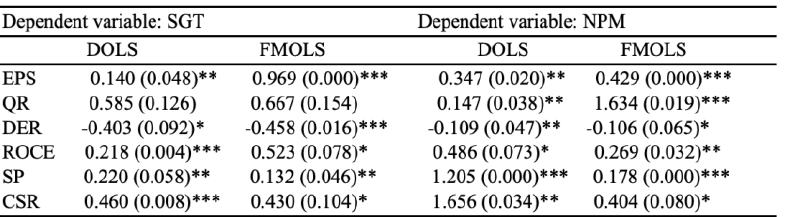
Table 5: Panel DOLS and FMOLS estimation